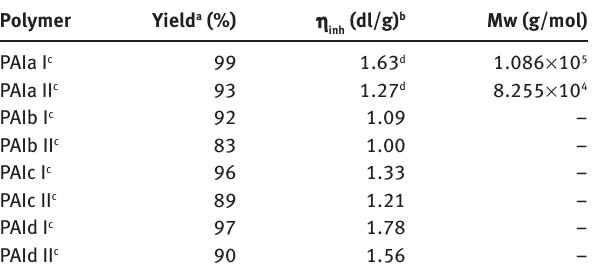
Table 2: Physical properties of PAIs synthesized by two methods.